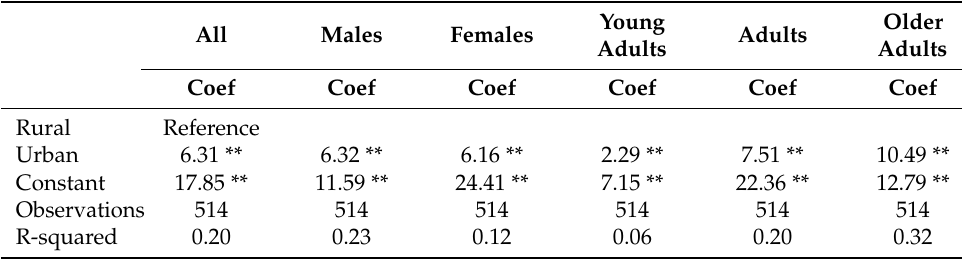
Table A1. Regression outputs for urban/rural